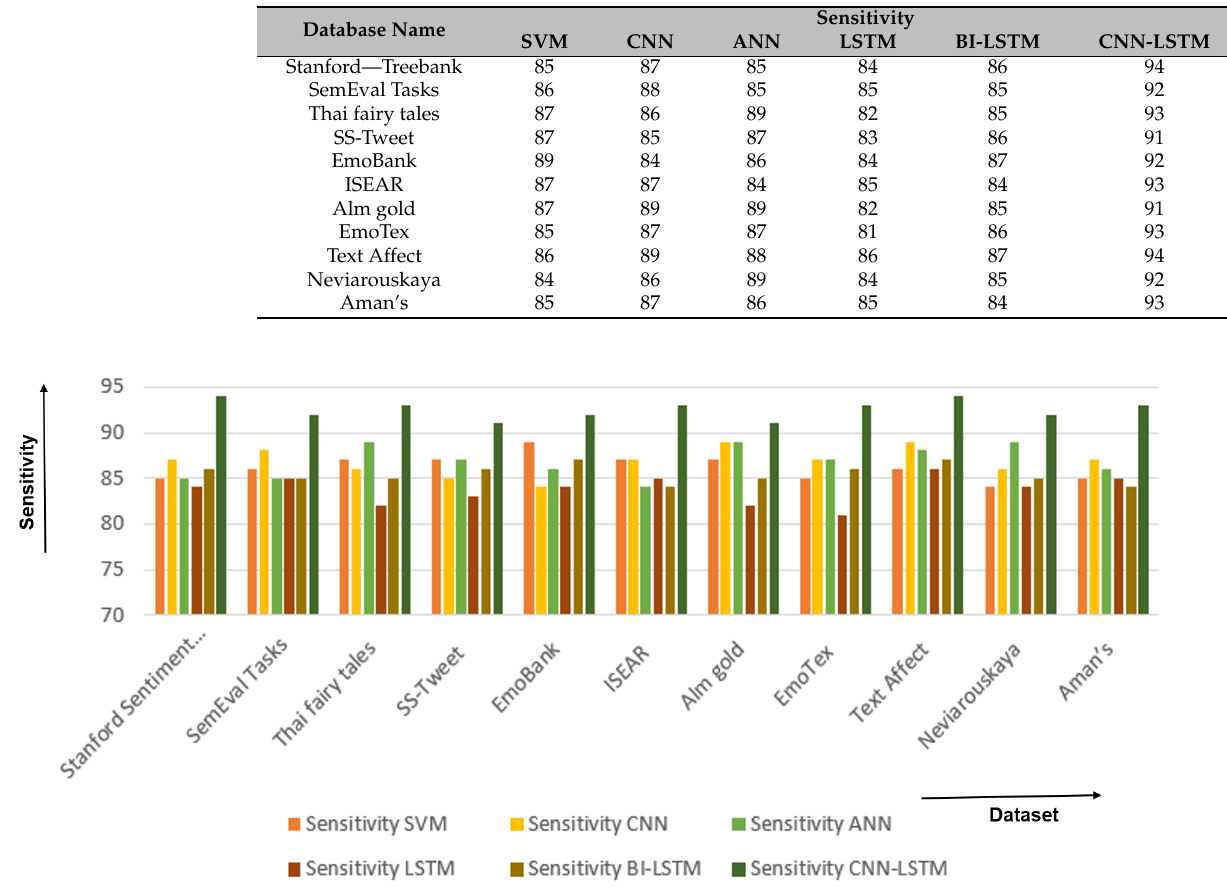
Table 8. Performance analysis for BOW + IF-IDF with CNN-LSTM based on sensitivity.